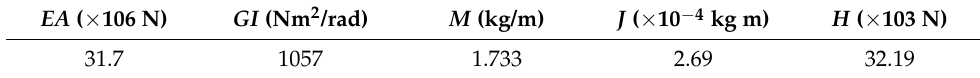
Table 1. Physical and mechanical parameters of iced conductor.